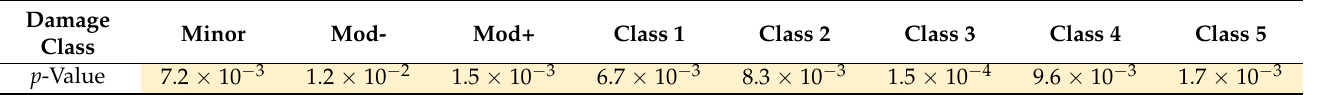
Table 2. Results of significant difference test for Mashiki Town and Uki City in R of each damage class (yellow indicates a significant difference was determined).